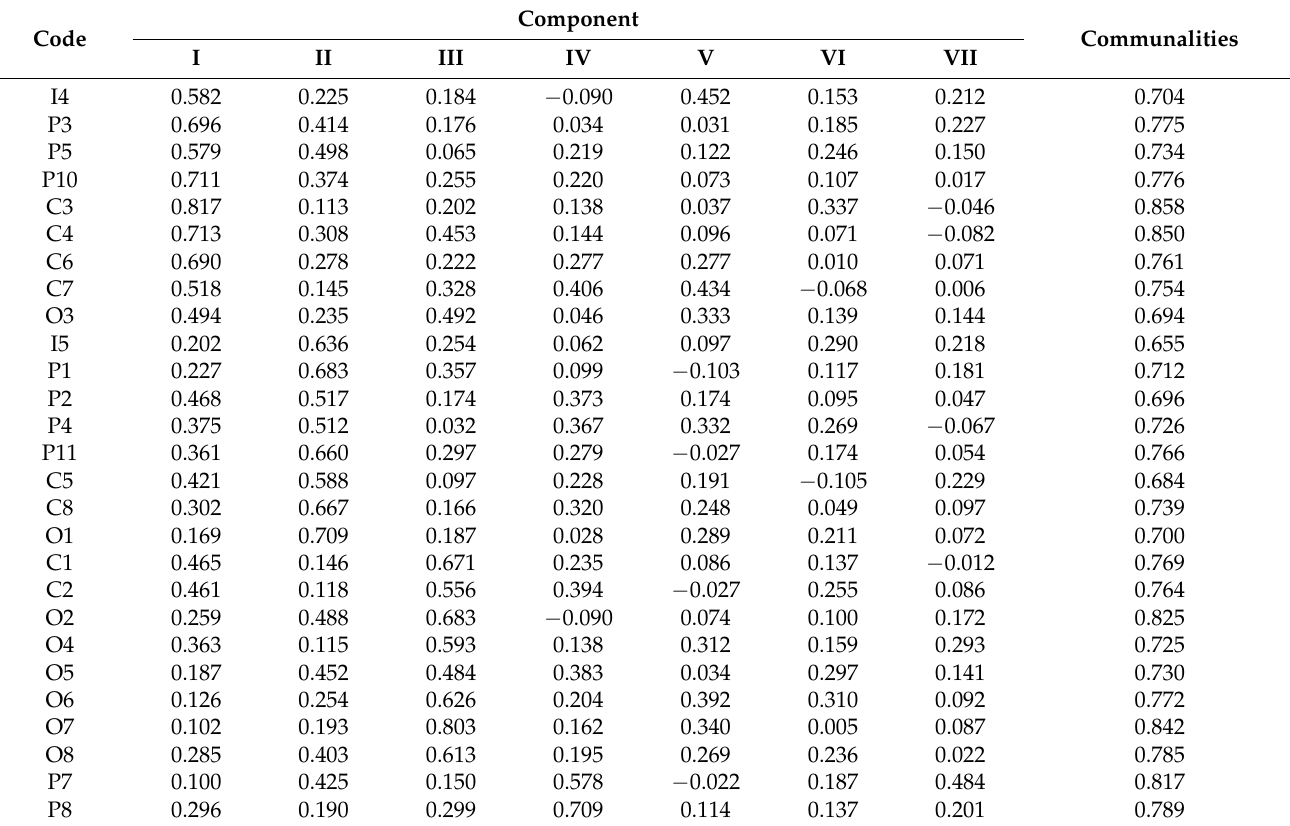
Table 9. Rotated component matrix and communalities of the CSFs in ULS